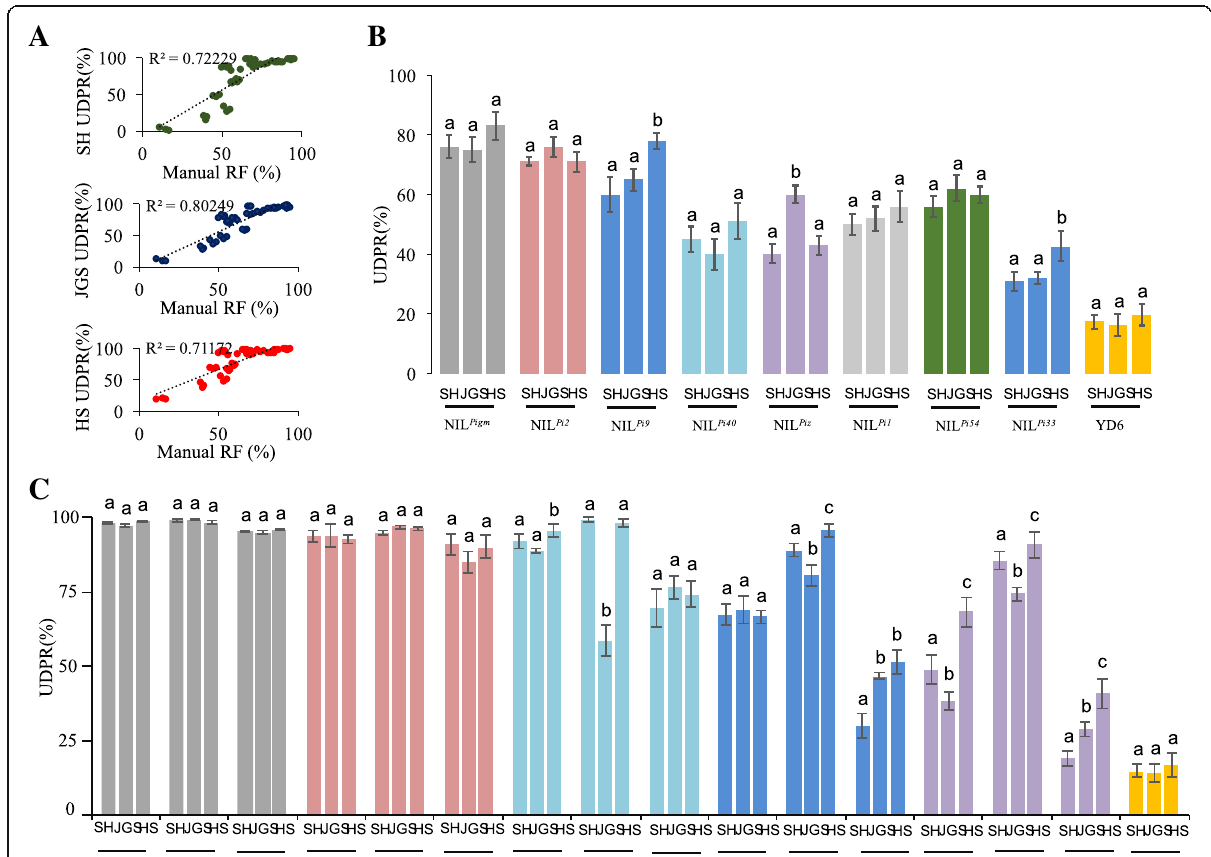
Fig. 5 Resistance performances of PPLs in the three blast nurseries. a Relationship between HPP of PPLs at three disease nurseries and the RF of PPLs in artificial inoculation evaluation; b Resistance variation of NILs among different disease nurseries; c Resistance variation of PPLs among different disease nurseries. SH: Shanghang; JGS: Jinggangshan; HS: Huangshan; Different lower-case letters indicate significant differences at the P < 0.001 level by one-way